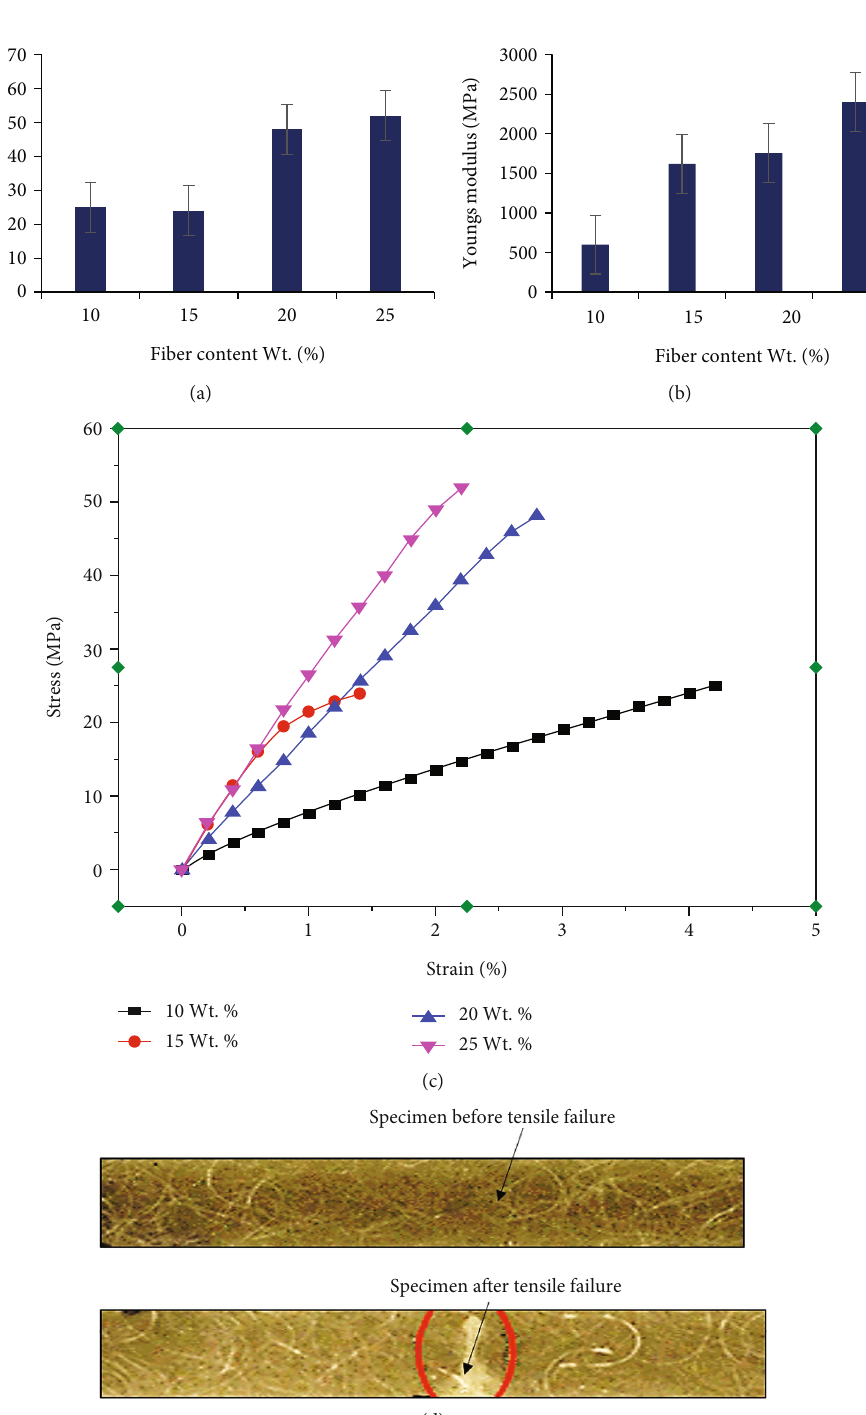
Figure 3: (a) Tensile strength vs. fi ber content and (b) Young ’ s modulus vs. fi ber content. (c) Stress vs. strain diagram for composite specimens with di ff erent wt.% of bamboo fi ber reinforcements. (d) Specimen before and after tensile